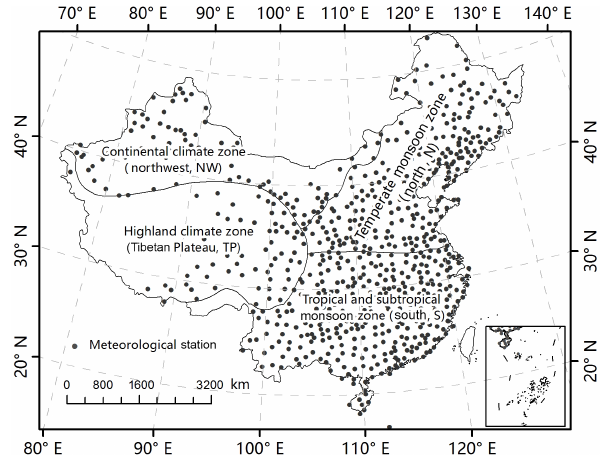
Figure 1. Distribution of the 713 meteorological stations used in this study. China is divided into four regions based on climatic type. The two non-monsoon regions are the continental climate zone (northwest – NW) and the highland climate zone (Tibetan Plateau – TP). The monsoon region is divided into two regions: the trop- ical and subtropical monsoon zone (south – S) and the temperate monsoon zone (north –